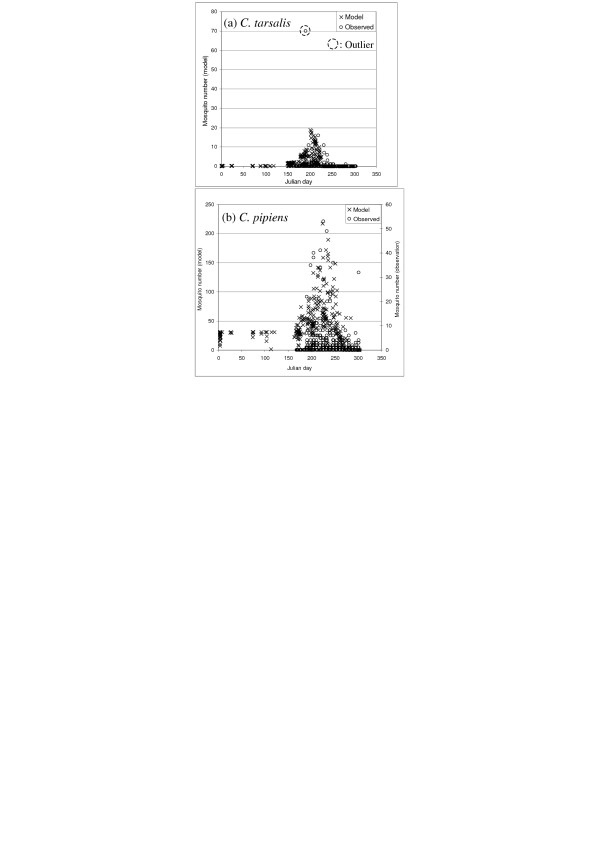
A comparison of the model outputs and the observed mosquito numbers. (a) C. tarsalis and (b) C. pipiens. Data for all traps are mapped together. In the model calculations, the initial egg number is set at 100.